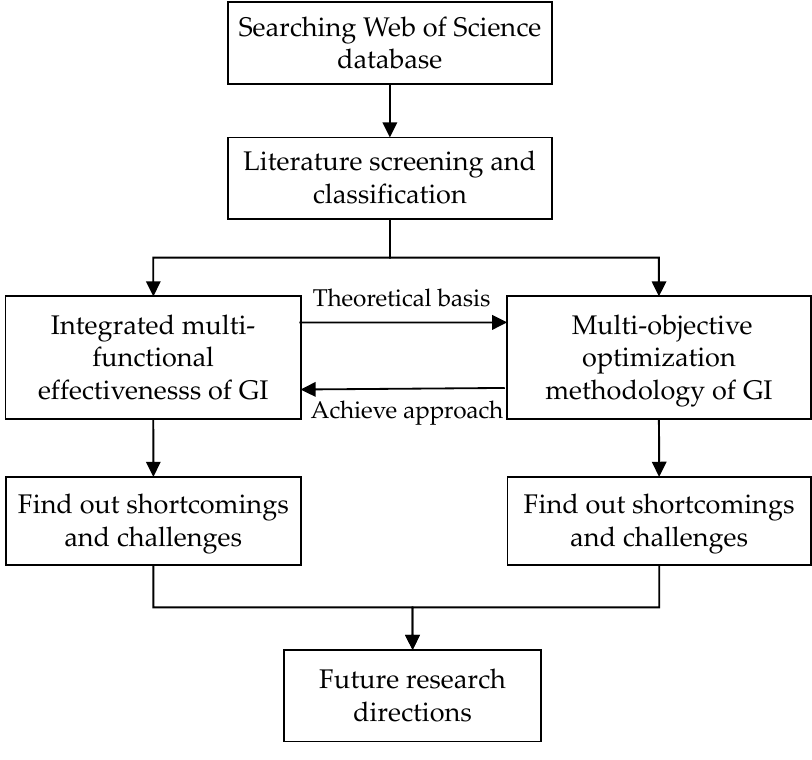
Figure 1. Main steps of this study.